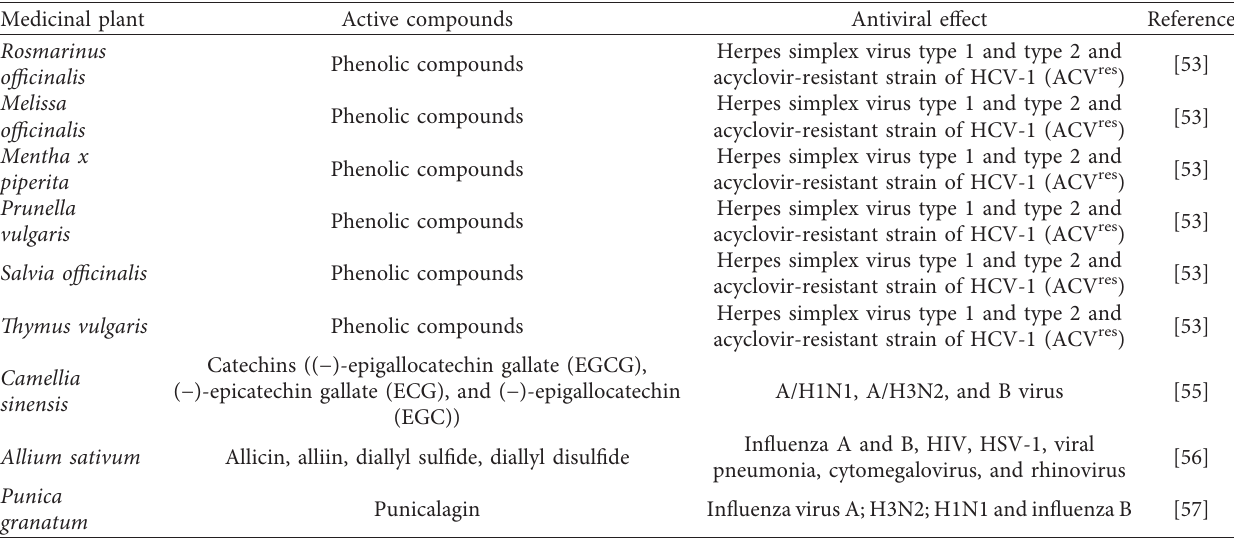
Table 1: Antiviral effect of medicinal plants.